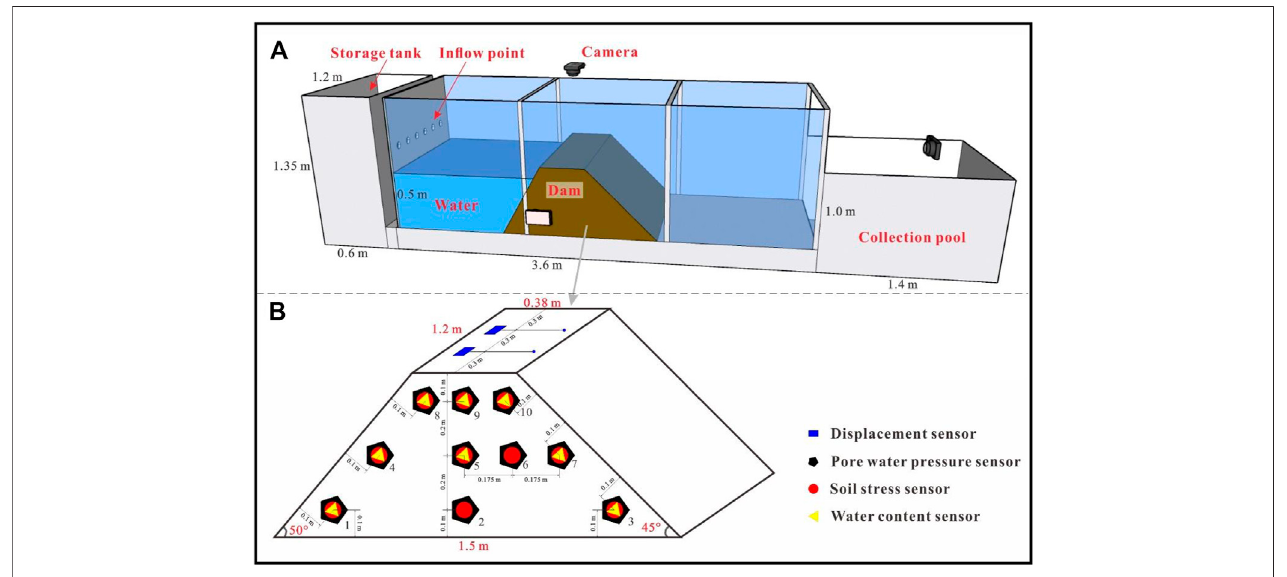
FIGURE 4 | Schematic diagram of the experimental setup. (A) Developed model test chamber and (B) sensors layout in the test model.